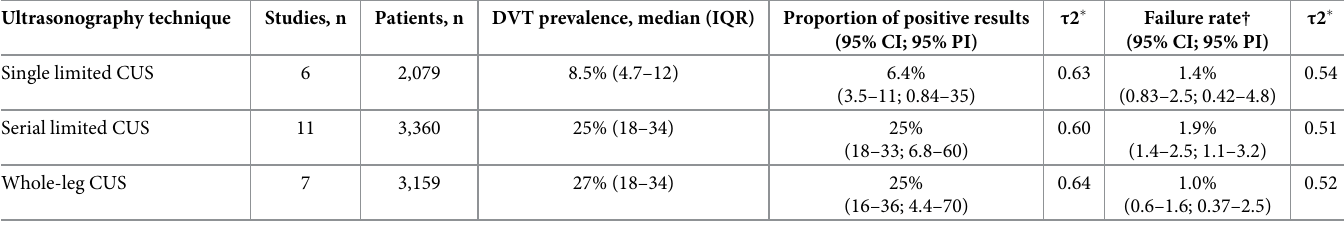
Abbreviations: CI: confidence interval, CUS: compression ultrasonography, PI: prediction interval � Tau-squared ( τ 2 ) represents the between-study variance and indicates the degree of heterogeneity.